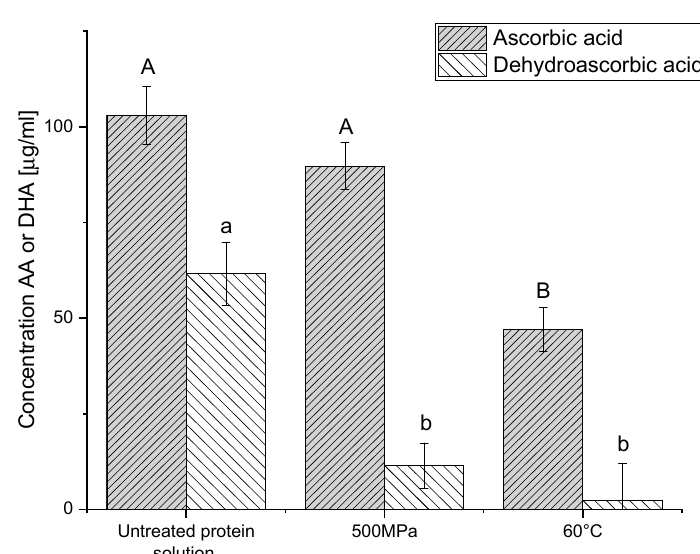
Figure 7. Concentration of ascorbic acid and dehydroascorbic acid in the untreated protein solutions and after gelation by pressure and heat. Different letters indicate significant differences ( p < 0.05) for the same compound.